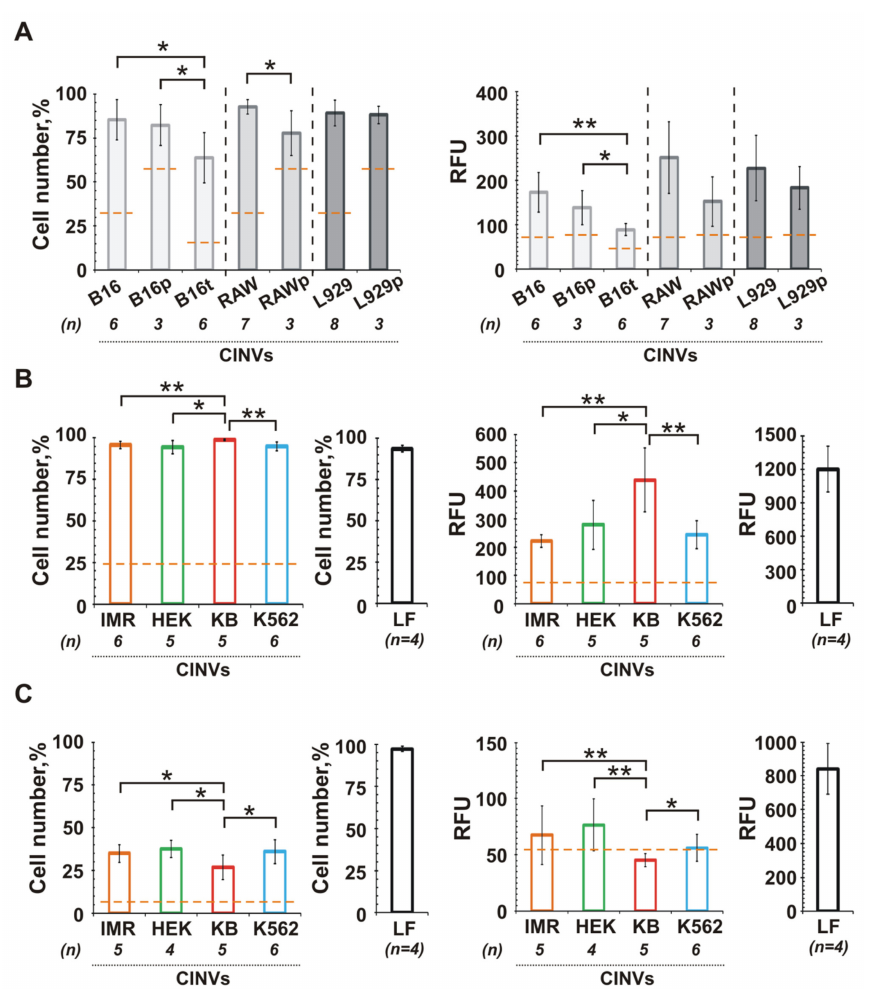
Figure 4. Delivery of FAM-ON mediated by CINVs, derived from various cellular sources. B16 ( A ), KB-3-1 ( B ) , and K562 ( C ) cells were incubated with 50 µ g FAM-ON loaded CINVs. The origin of CINVs is shown at the bottom of each graph. The effect of surface receptors of recipient cells on CINV uptake was studied for B16 cells ( A ); symbols after the CINV source are as follows: CINVs without prefix (B16, RAW, L929) indicate no cell pre-treatment; CINVs with prefixes “p” and “t” (B16p, RAWp, L929p, and B16t)—cells were pre-incubated with proteinase K or trypsin-EDTA, respectively. The level of FAM-ON self-penetration into the cells (CTRO) is indicated by an orange dashed line. Cell number is the percentage of FAM-positive cells in a population. RFU is relative fluorescence units detected in a cell population. The FAM-ON delivery mediated by Lipofectamine 2000 is indicated as LF. The number of measurements is indicated as n . Experimental data are presented as the mean ± SD. Statistical analysis was performed using the Mann–Whitney U test and was carried out between the CINV’s experimental groups ( n = 3–8); * p ≤ 0.05, ** p ≤